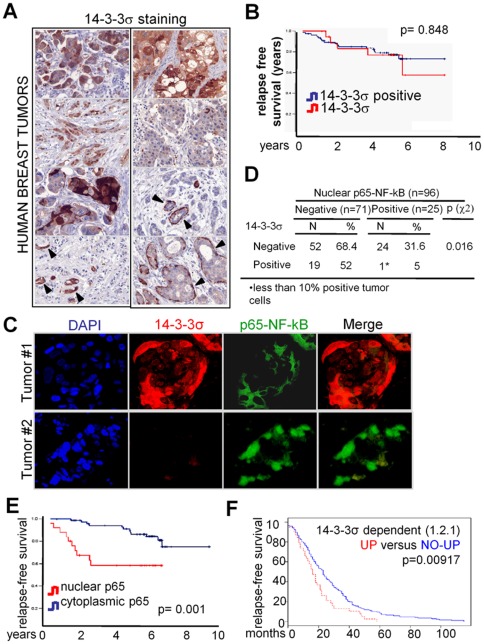
14-3-3σ-dependent NF-κB activity correlates with poor prognosis in breast cancer patients.(A) Representative tumors showing different patterns of 14-3-3σ expression, that was distributed both in cytoplasm and nucleus of tumor cells. Consistently, positive 14-3-3σ staining was observed in myoepithelial cells of normal ducts and ductal carcinoma in situ (arrowheads). (B and E) Kaplan-Meier curves depict cumulative disease-free survival of breast cancer patients stratified by the absence of 14-3-3σ (B) and by the presence of nuclear p65 (E). (C) Double IF of representative breast tumors showing that nuclear p65 distribution was restricted to the 14-3-3σ negative samples (D) Cross-tabulation of 14-3-3σ expression and NF-κB activation (as determined by nuclear p65) in the different tumors analyzed. (F) Kaplan-Meier curve depict relapse-free survival of breast cancer patients stratified by up-regulation of 14-3-3σ-dependent signature in the primary tumors.